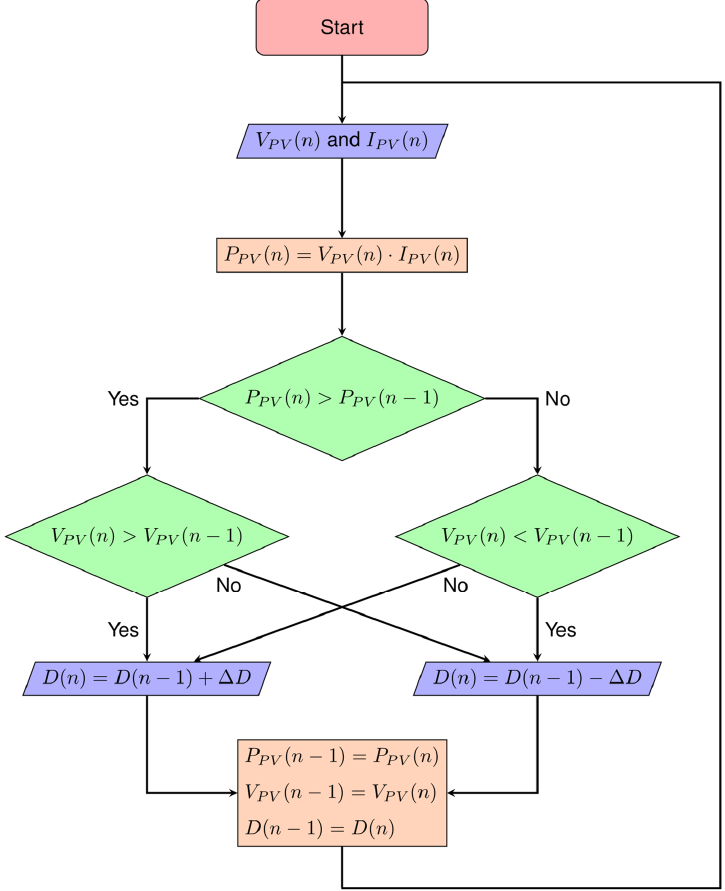
Figure 30. Flowchart of the PO algorithm, one of the MPPT methods. A Simulink model of the system was made using the built-in battery photovoltaic array blocks. The model is illustrated in Figure 31.